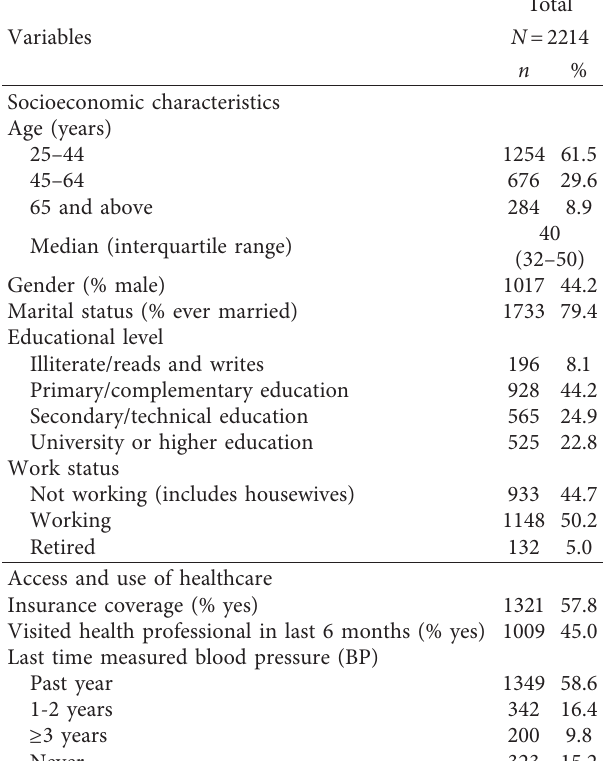
Table 2: Descriptive characteristics of study